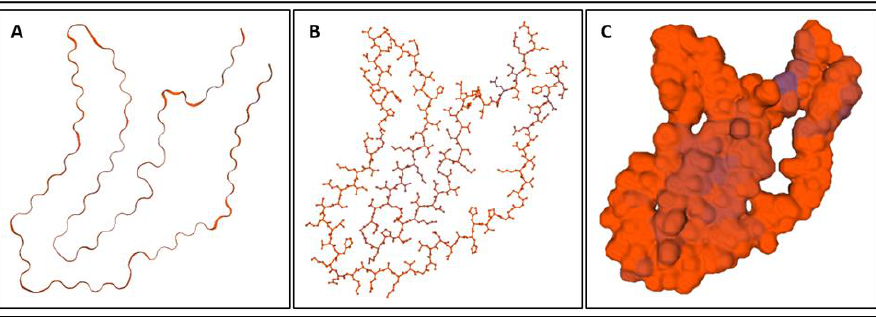
Figure 3. ( A ) A cartoon model, ( B ) a ball-and-stick model, and ( C ) a surface model of UCH-L1 [26].